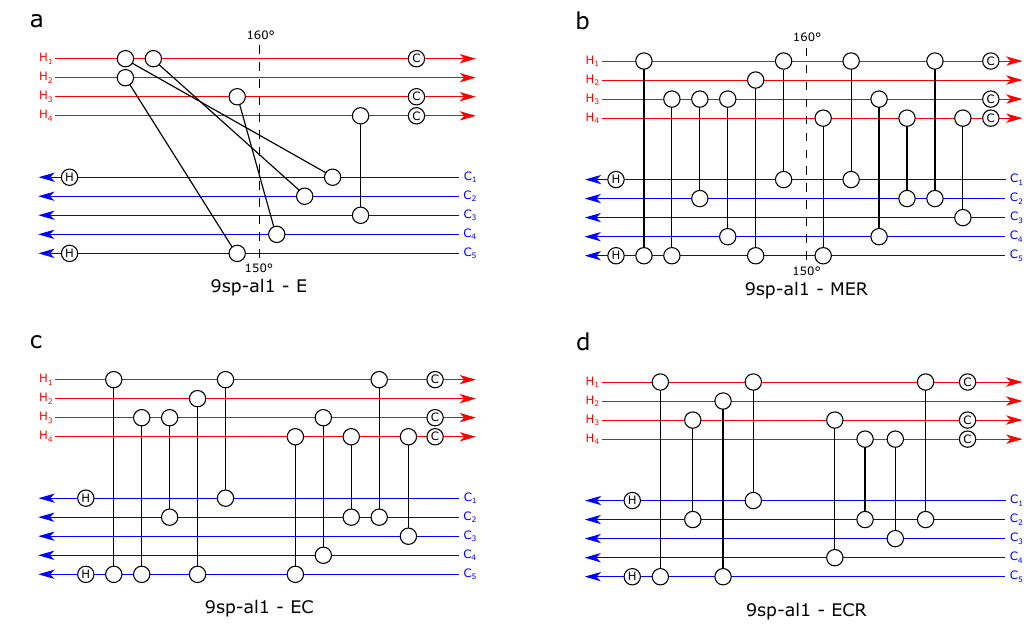
Figure 5. Four designed HEN for the 9sp-al1 problem [14]: ( a ) existing network of an aromatic complexes in Europe; ( b ) maximum Energy Recovery design of the aromatic complexes; ( c ) grassroot (new) design with optimisation for the Energy-Capital tradeoff; and ( d ) retrofit design with optimisation for the Energy-Capital tradeoff.